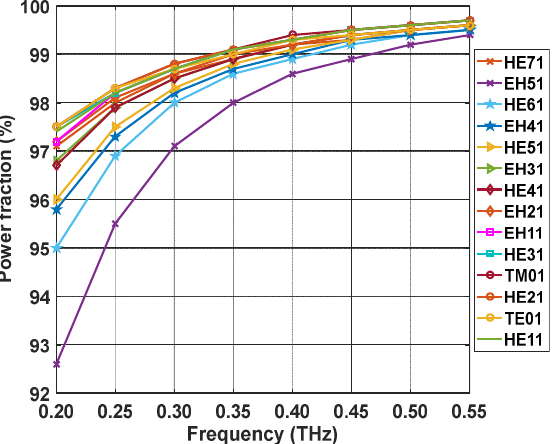
Figure 11. Numerical aperture as a function of frequency for different modes.